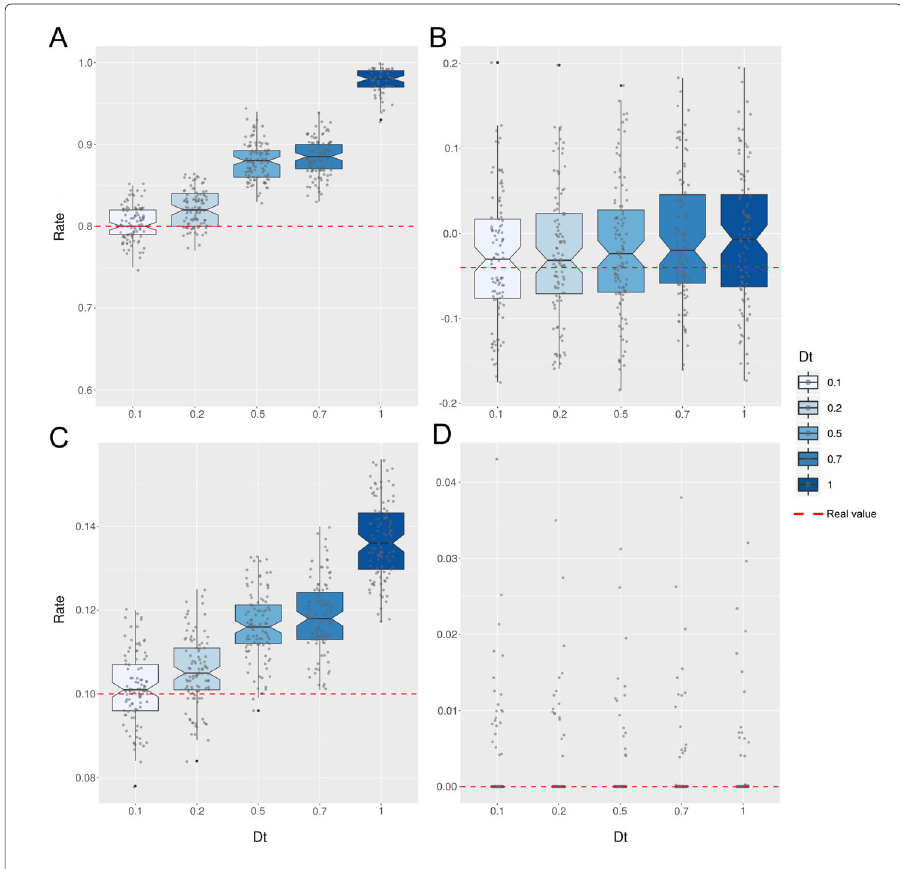
Fig. 3 Distribution of parameter estimates for increasing dt values. On each experiment included in the SHDP simulation study the inferential procedure has been applied by setting dt value to (0.1, 0.2, 0.5, 0.7, 1). Each boxplot describe the distribution of 100 independent estimates obtained for a specific parameter/dt pair. Four parameters are shown: a ) a positive net duplication rate, γ 1 (0.8); b ) a negative net duplication rate λ λ γ 1 1 (-0.05); c ) a positive differentiation rate, 1,2 (0.1). d ) an absent differentiation path, 3,2